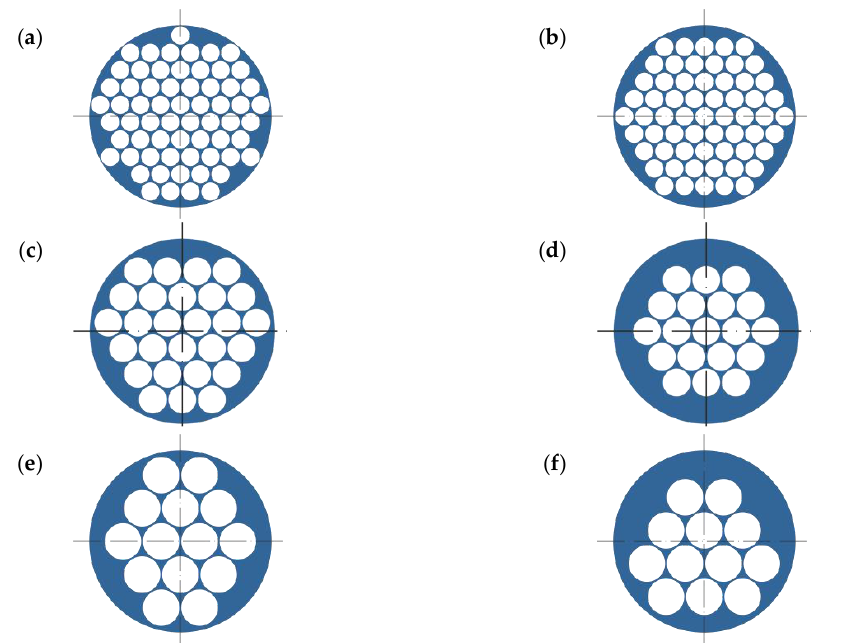
Figure 2. Pattern of spheres distribution in odd and even layers of beds consisting of spheres with a diameter of:( a,b ) 2 mm; ( c,d ) 3 mm; ( e,f ) 4 mm.